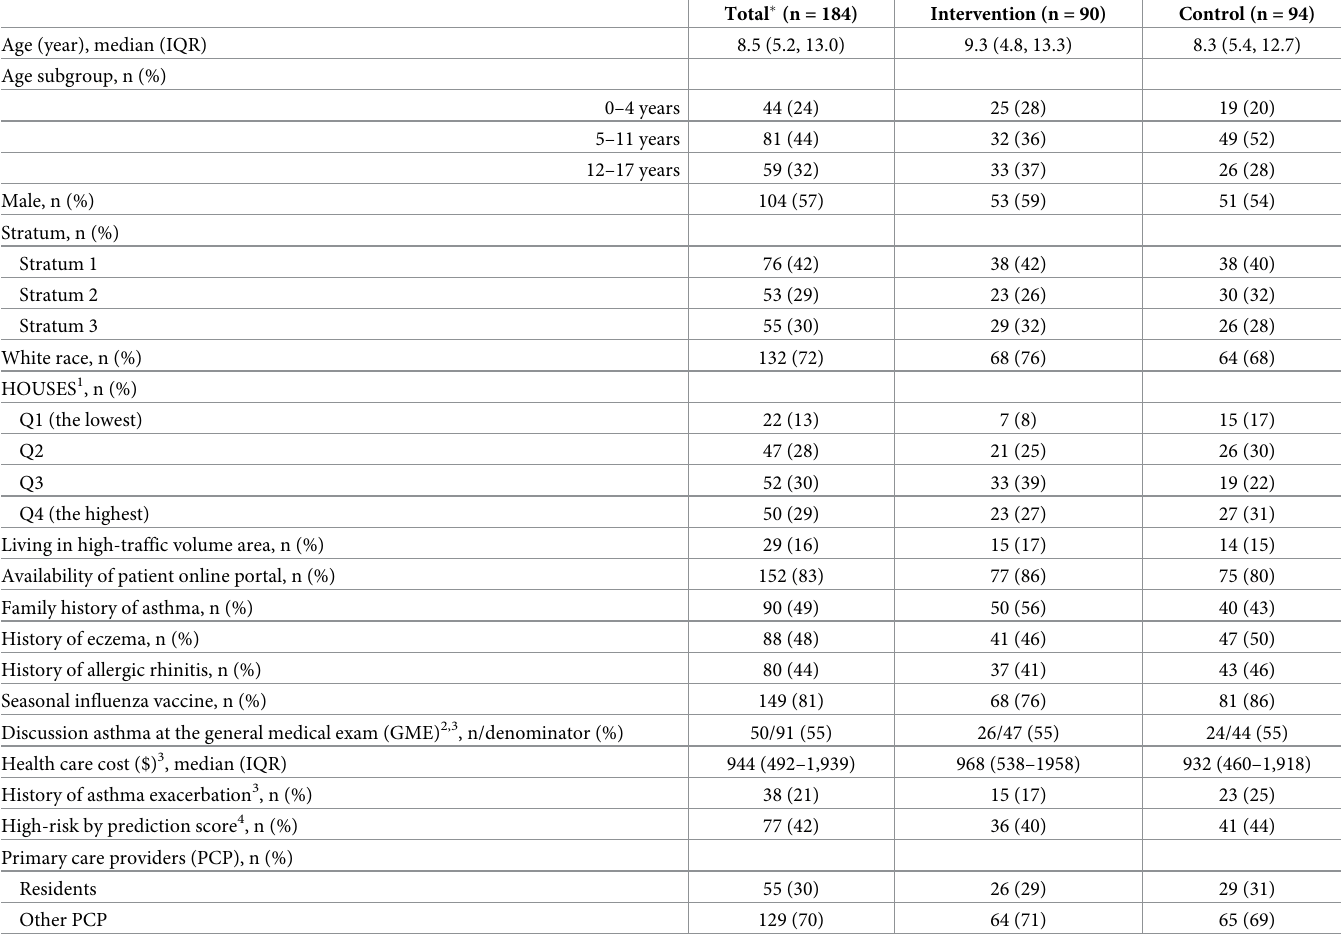
Table 1. Baseline characteristics of study subjects between the intervention and the